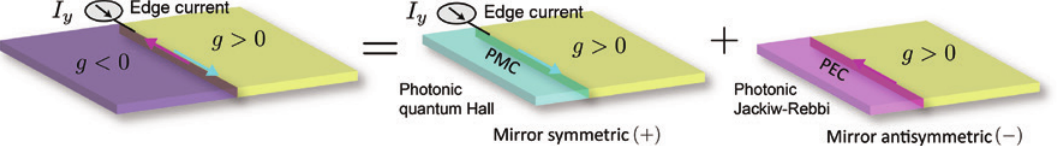
Figure 2: The interface of two optical isomers with positive + g and negative − g gyrotropy. In the Drude model, this corresponds to reversed magnetic biasing ± B two chiral (unidirectional) subsystems with perfect magnetic conductor (PMC) and perfect electric conductor (PEC) boundary conditions. PMC and PEC are mirror symmetric ( + ) and mirror antiysmmetric (−) respectively, designating PQH and PJR states. The particular mirror symmetry ( ± ) dictates how the electromagnetic field transforms into the virtual photon P